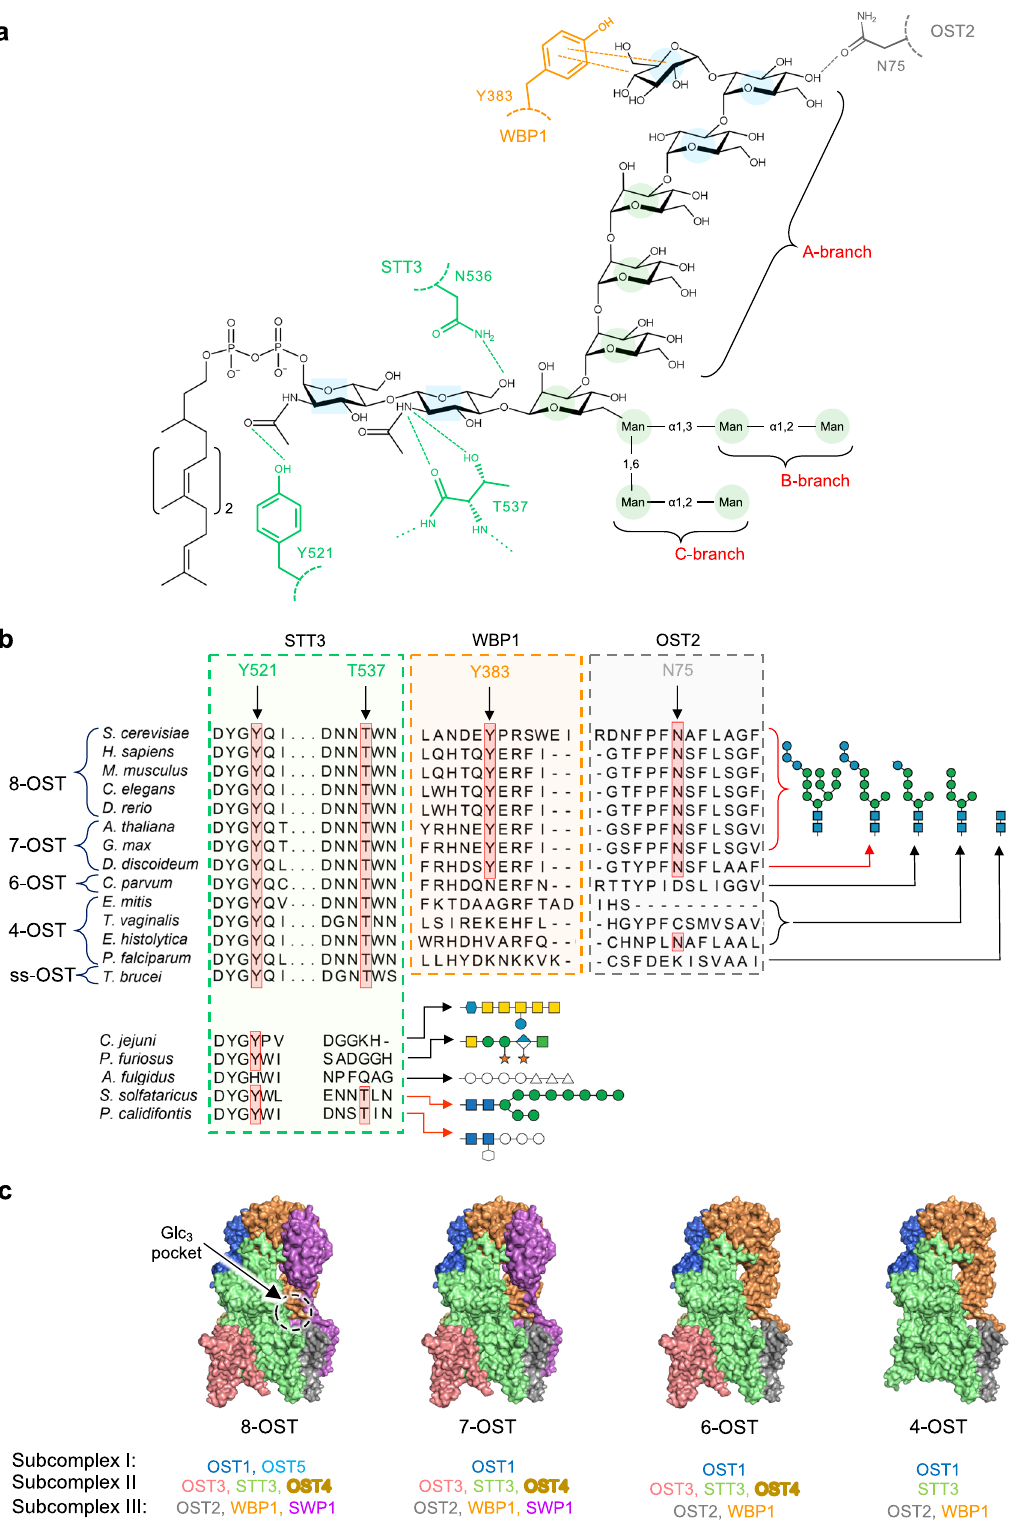
Fig. 4 | Conservation of LLO binding motifs in OST enzymes. a Interactions of yeast OST with GlcNAc 2 Man 9 Glc 3 shown as a structure. Side chains of STT3, OST2, andWBP1subunitsarecoloredgreen,gray,andorange,respectively,andlabeledin single-letter code. Dashed lines indicate hydrogen bonds or CH2- π interactions b Protein alignment of OST subunits involved in glycan recognition. For STT3, residues518 – 523and534 – 539arealigned;forWBP1,residues378 – 389arealigned,